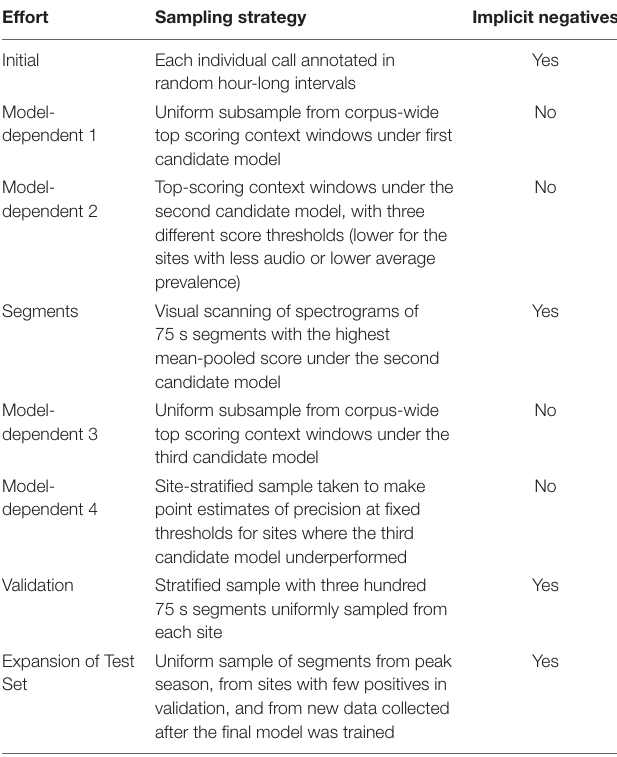
TABLE 1 | Audit efforts and their sampling